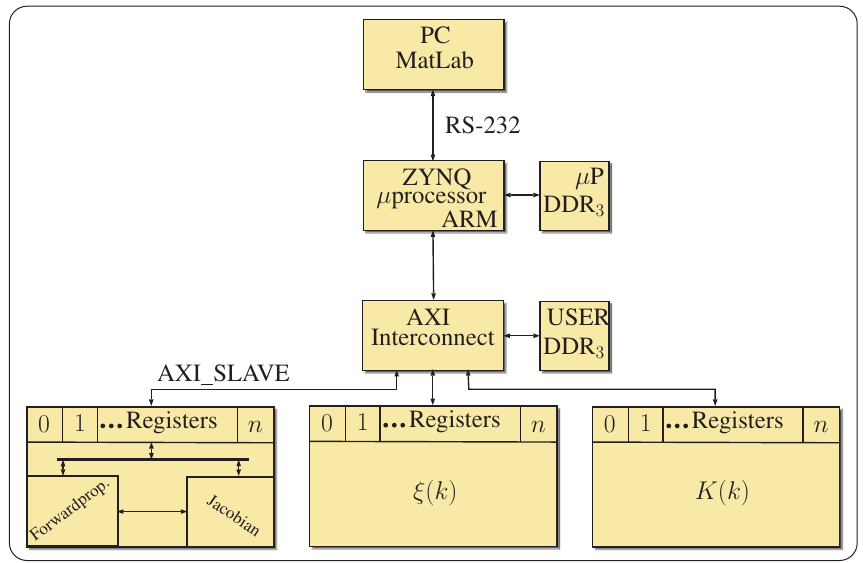
Figure 12. Full architecture implemented in